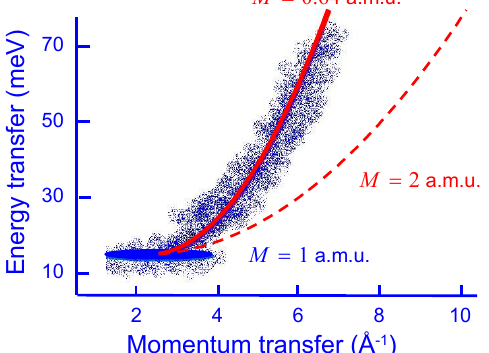
Figure 4. Experimental INS results from H 2 in carbon nanotubes, with incident neutron energy E i = 90 meV; adapted from Figure 1 of Ref. [23]. The translation motion of the recoiling H 2 molecules causes the observed continuum of intensity, usually called “roto-recoil” (white-blue ribbon), starting at the well visible first rotational excitation of H 2 being centered at E rot ≈ 14.7 meV and K rot ≈ 2.7 Å − 1 (blue ellipsoid). The K – E position of the latter is in agreement with conventional theory. In contrast, a detailed fit (red parabola; full line) to the roto-recoil data reveals a strong reduction of the effective mass of recoiling H 2 , which appears to be only 0.64 a.m.u. (The red dashed line, right parabola) represents the conventional-theoretical parabola with effective mass 2 a.m.u.) For details of data analysis, see [23]. (Reproduced from Ref. [10], with permission from Quanta